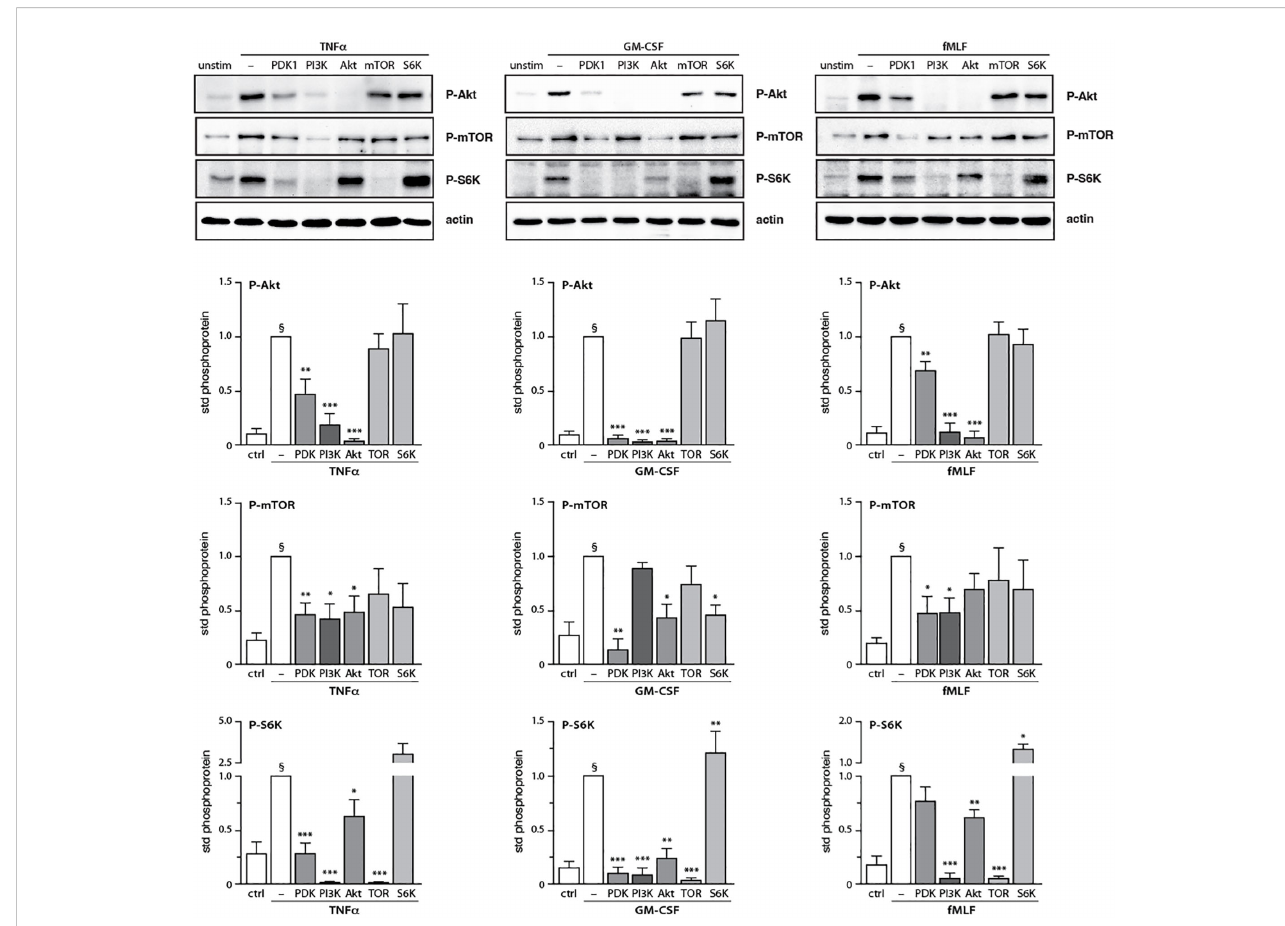
FIGURE 7 Inter-relationships between PI3K and its signaling partners in human neutrophils. Neutrophils were pre-treated (15 min, 37°C) with the following inhibitors or their diluent (0.1% DMSO): 10 m M LY294002 (PI3K inhibitor); 5 m M BX-912 (PDK1 inhibitor); 10 m M Akt inhibitor VIII (Akt inhibitor); 100 nM rapamycin (mTOR inhibitor); or 10 m M PF-4708671 (S6K inhibitor). The cells were then stimulated or not (10 min, 37°C) with 100 U/ml TNF a , 1 nM GM- CSF, or 100 nM fMLF. The samples were processed for immunoblot analysis of P-Akt (S473), P-mTOR (S2448), P-S6K (T389), as well as b -actin (loading control). Representative blots are shown, along with compiled data (mean ± s.e.m.) from at least 3 independent experiments (in which phosphoprotein values were standardized versus actin and the resulting ratios were divided by that of the corresponding stimulus). *, p<0.05; **, p<0.01; ***, p<0.001 vs stimulus alone. §, p < 0.02 for unstimulated cells vs